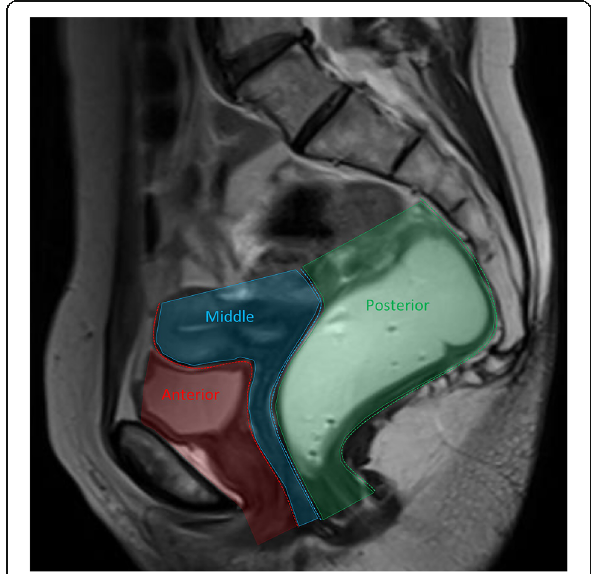
Fig. 2 Pelvic compartments. Sagittal midline T2-TSE image representing the three pelvic compartments in different